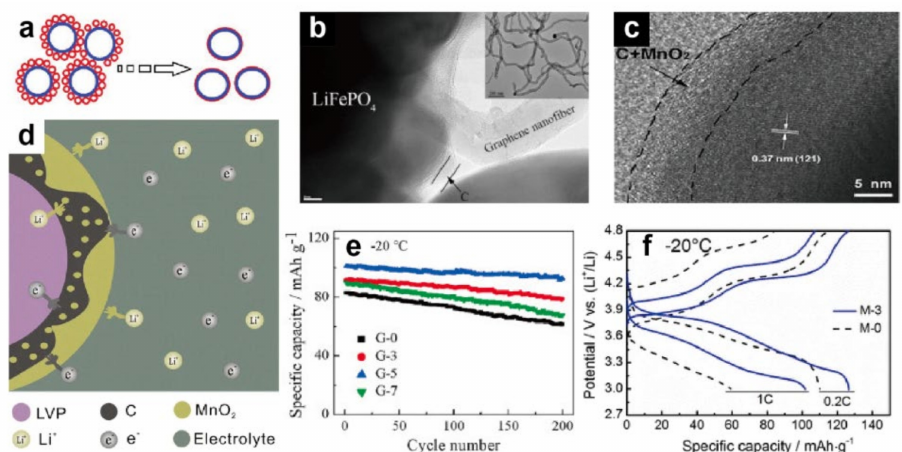
Figure 2. ( a ) Schematic diagram of carbon coating [44]. Reproduced with permission from Elec- trochimica Acta; published by Elsevier, 2011; ( b ) TEM image of LiFePO 4 /C with bridge network and graphene nanofiber as the insert [48]. Reproduced with permission from Electrochimica Acta; published by Elsevier, 2016; ( c ) HRTEM image of MnO 2 -coated LVP/C cathode, and ( d ) schematic illustration of its structure and diffusion path [50]. Reproduced with permission from Journal of Materials Science; published by Springer, 2017; ( e ) cycling performance of LiFePO 4 /C with different contents of coating at 1 C and − 20 ◦ C, where G − 0, G − 3, and G − 7 represent the composites with 0 wt.%, 3 wt.%, and 7 wt.% graphene nanofibers, respectively [48]. Reproduced with permission from Electrochimica Acta; published by Elsevier, 2016; ( f ) first charge and discharge curves of M − 3 and M − 0 at − 20 ◦ C [50]. Reproduced with permission from Journal of Materials Science; published by Springer,